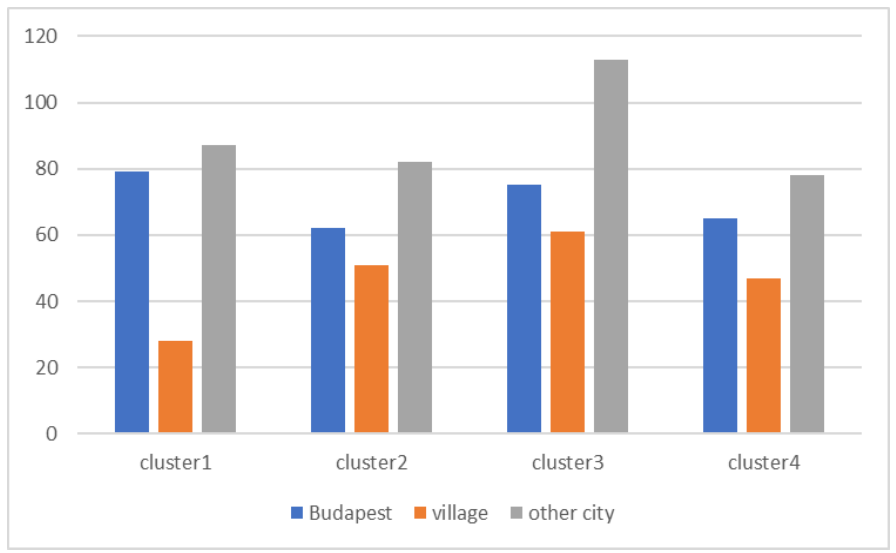
Figure 4. Distribution of respondents by place of residence.